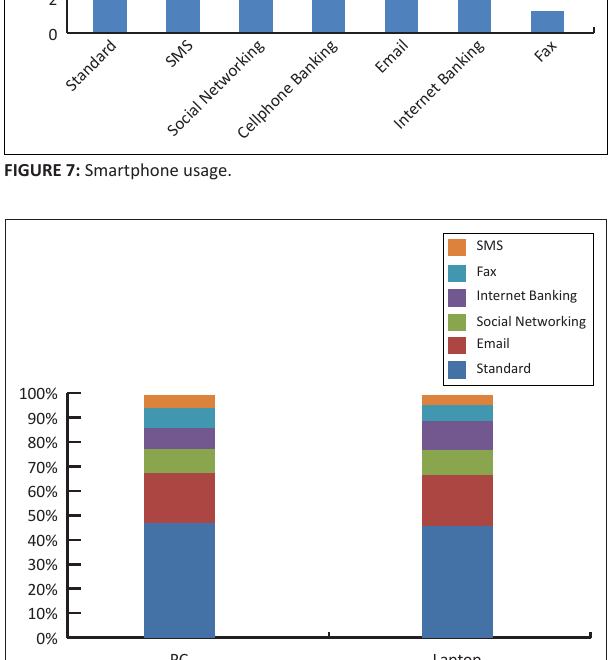
FIGURE 8: Personal computer and laptop usage.